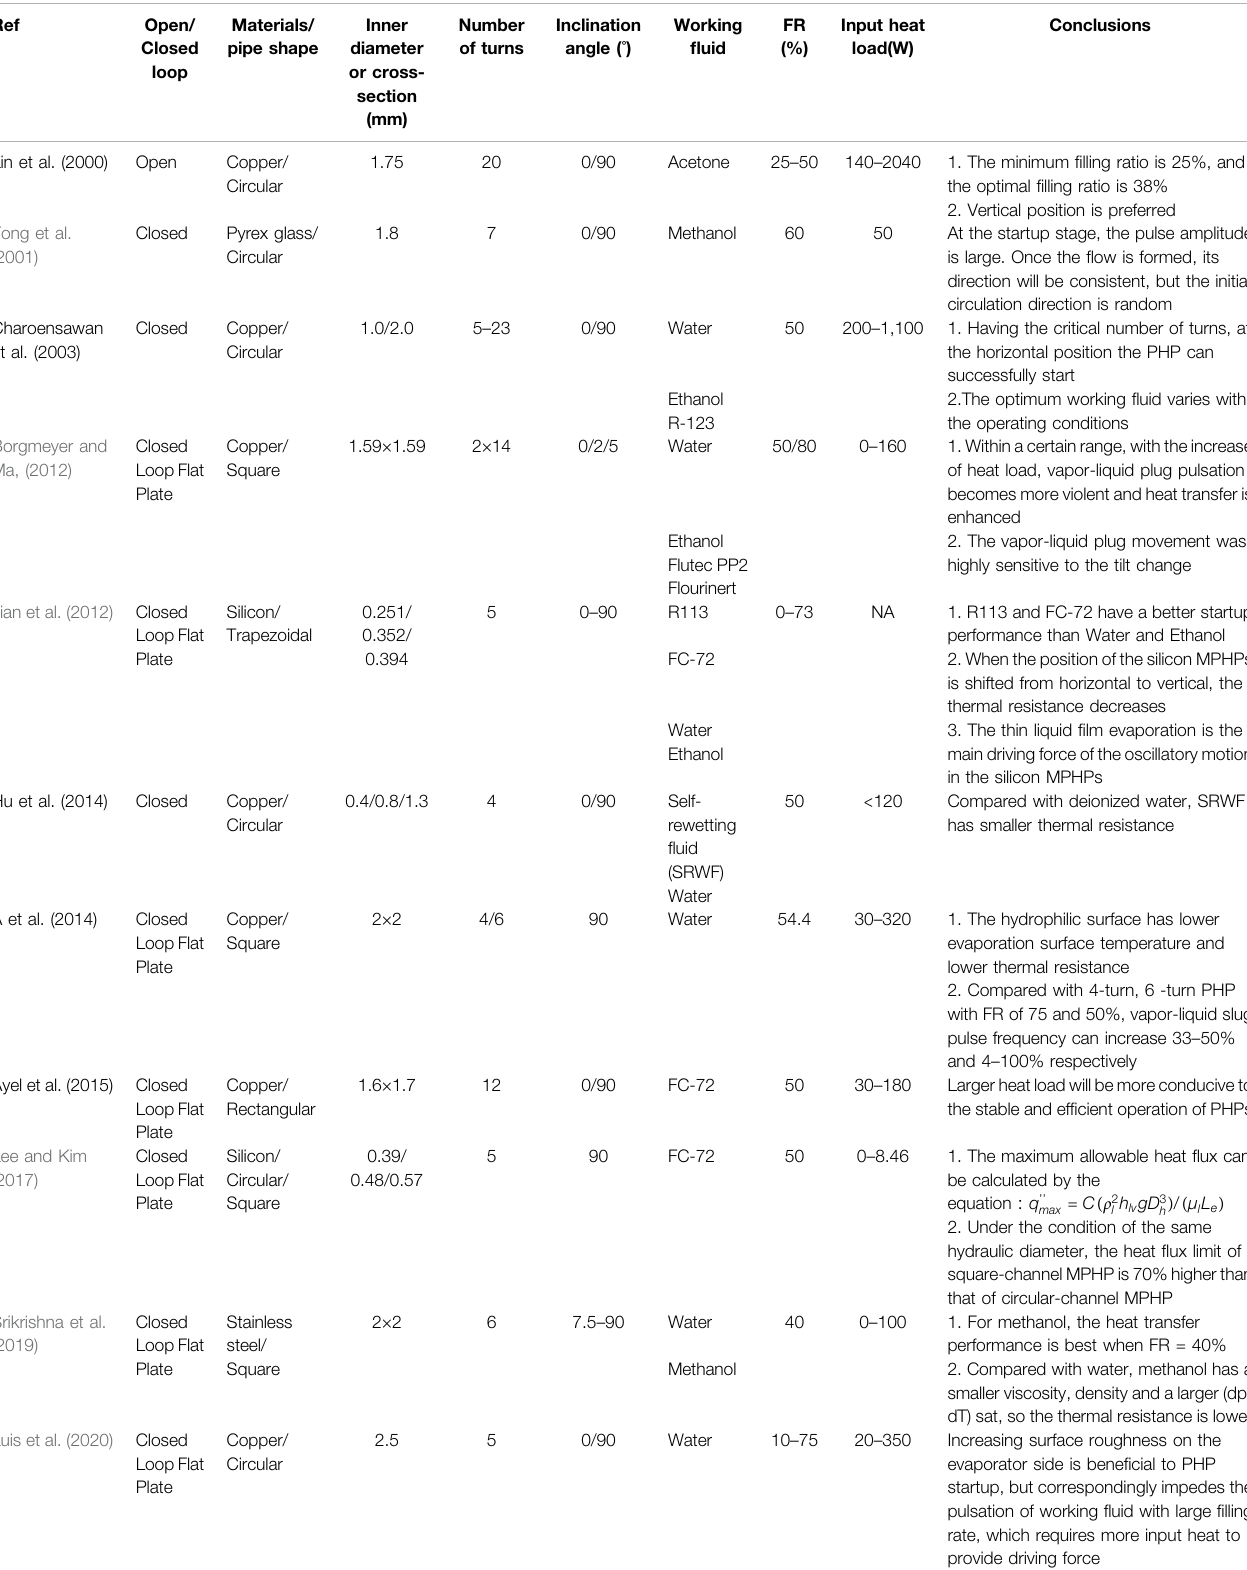
TABLE 2 | Summary of experimental investigations on factors affecting the performance of